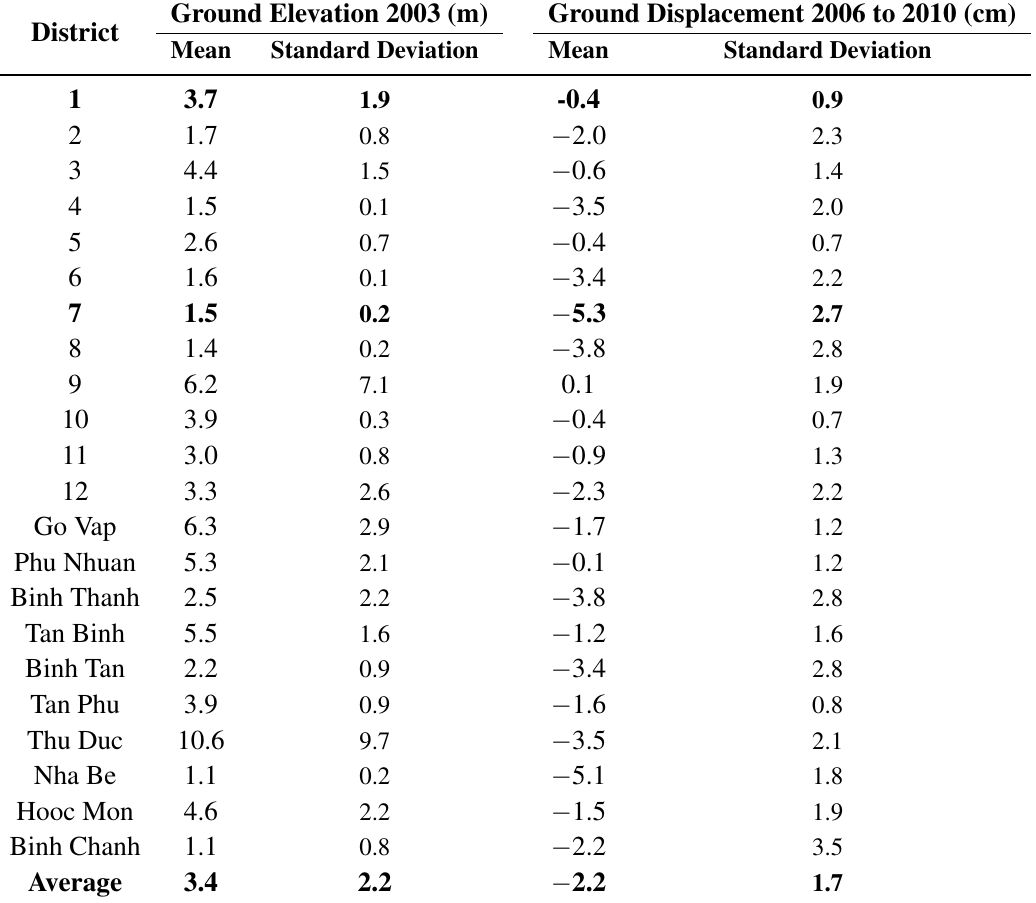
Table 3. District displacement. The bold rows for Districts 1, 7 and average indicate the most stable area, the most unstable area and the average,